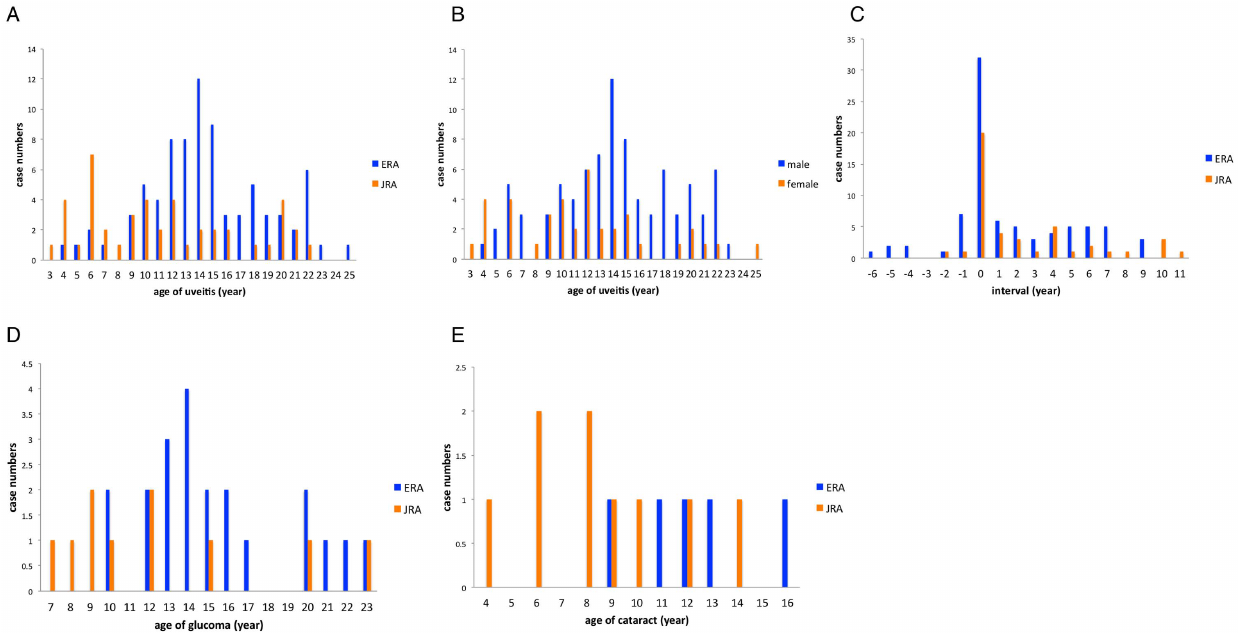
Figure 3. (A and B) Distribution of diagnostic age of uveitis in 125 uveitis patients considering JIA subtype and sex. The mean age of uveitis was 15.1 6 4.4 years for patients with ERA, 11.8 6 5.6 years for JRA, 14.7 6 4.8 years for males, and 12.1 6 5.5 years for females. ( C ) Distribution of time interval for 125 patients considering JIA subtype. In the means time elapsed between diagnosis of JIA and uveitis, with 0 being the point at which JIA was diagnosed, patients with negative elapsed time were diagnosed as having uveitis before they were diagnosed as having JIA. ( D ) Distribution of age of glaucoma in uveitis patients considering JIA subtype. The median age of glaucoma was 11.6 years for patients with JRA and 14.7 years for those with ERA. ( E ) Distribution of age of cataract in uveitis patients considering JIA subtype. The median age of cataract was 8.4 years for patients with JRA and 12.2 years for those with ERA.